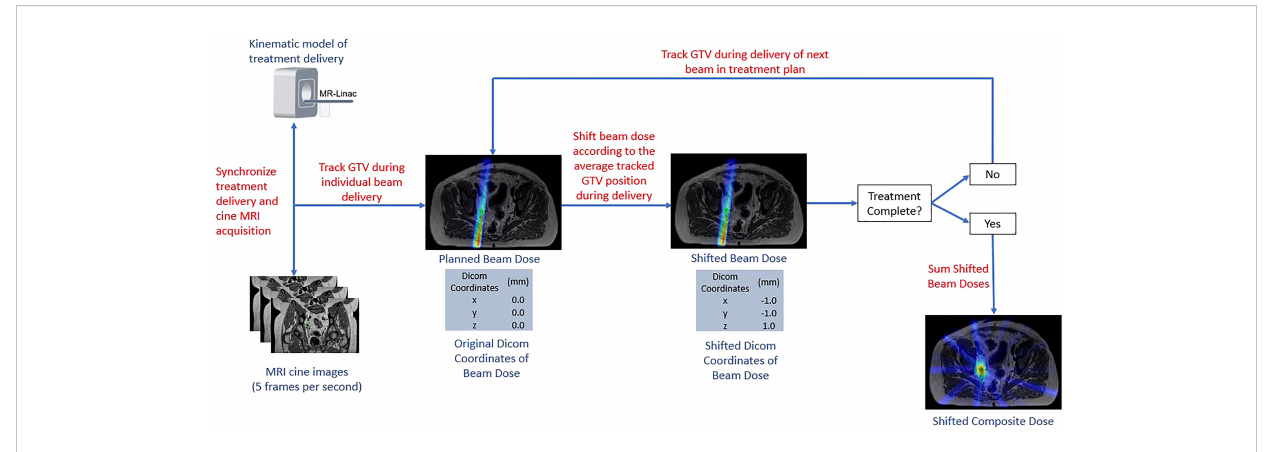
FIGURE 2 Overview of Intra-fraction Dose Accumulation Work fl